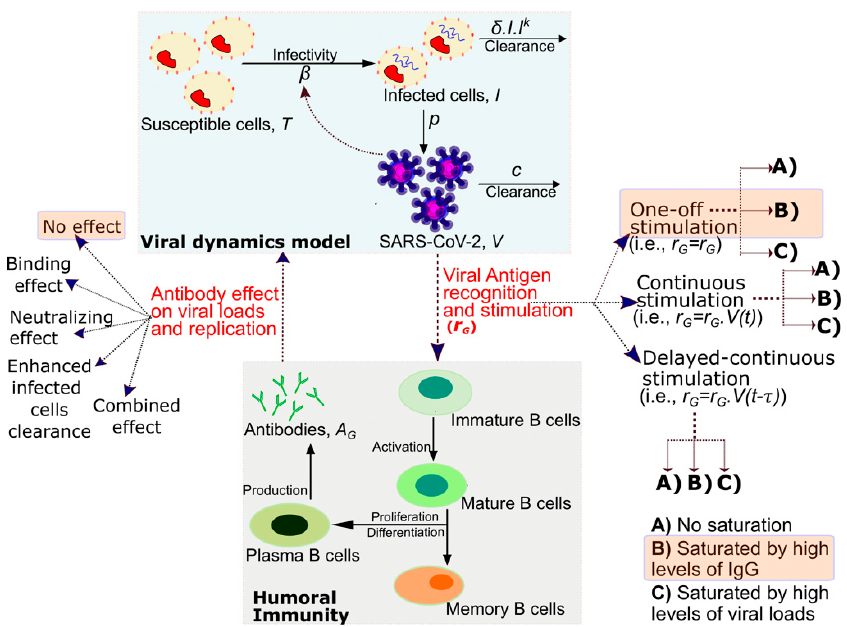
Figure 3. Mathematical model schematic of SARS-CoV-2 antibody generation and antiviral activity. The SARS-CoV-2 viral replication and antibody generation are displayed as two compartments. The SARS-CoV-2 viral antigen may trigger antibody immune response via one of three mechanisms: one-off stimulation, continuous stimulation, or delayed-continuous stimulation. For each mechanism, the antibody generation rate may proceed in 3 ways: no saturation, saturation by high levels of IgG, or saturation by viral load. The generation of antibodies may affect viral replication through viral binding effects, viral neutralization effects, via both mechanisms, or not at all. Two additional models containing antibody-assisted infected cell clearance are employed. In total, these multiple options give rise to 38 models. The components of the best-performing model are highlighted in orange rectangle